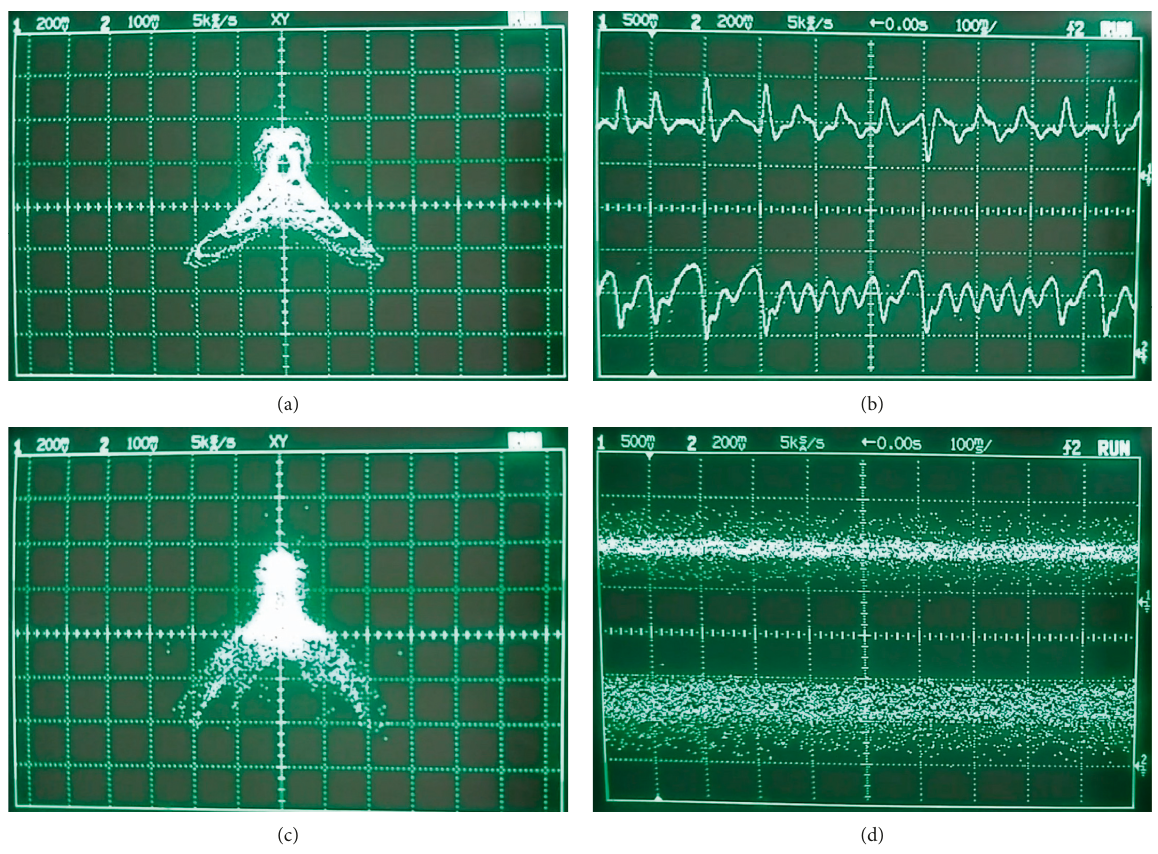
Figure 14: Implementation of ES in V4 of the MACM CS (20)–(24) in its DV. (a) Phase plane x x ( n ) and z ( n ) using τ � 0.01, (c) phase plane x ( n ) versus z ( n ) , and (d) evolution of state variables x ( n ) and z ( n ) using τ max �